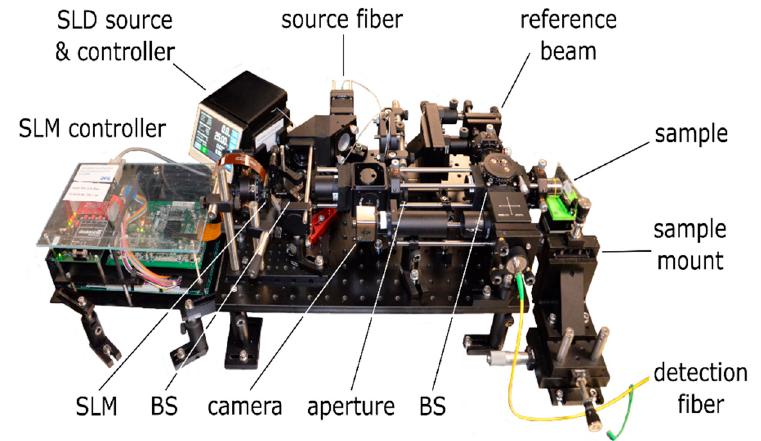
Figure 11. Photograph of a modular setup for independent wavefront manipulation at the sample and reference arm of a spectral domain OCT device. Abbreviations: SLM—spatial light modulator, BS—beam splitter. Image from [8], with